Question: Express in one sentence what the figure is showing.
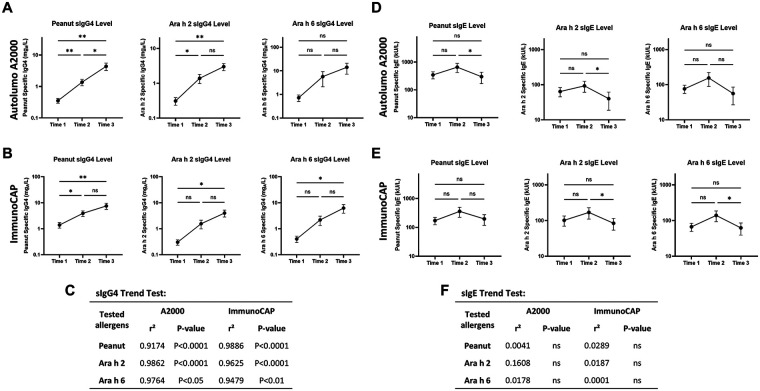
Answer: Longitudinal changes in peanut-specific antibody levels during OIT. (A,B) Levels of sIgG4 to peanut, Ara h 2, and Ara h 6 increased significantly over time, as measured on both the Autolumo A2000 Plus and ImmunoCAP platforms. (C) Linear trend analysis confirmed significant positive slopes for sIgG4. (D,E) In contrast, peanut-specific IgE levels showed no significant decline throughout treatment. (F) This was confirmed by trend analysis which indicated no significant downward slope for sIgE. * P < 0.05, ** P < 0.01, ns, not significant.